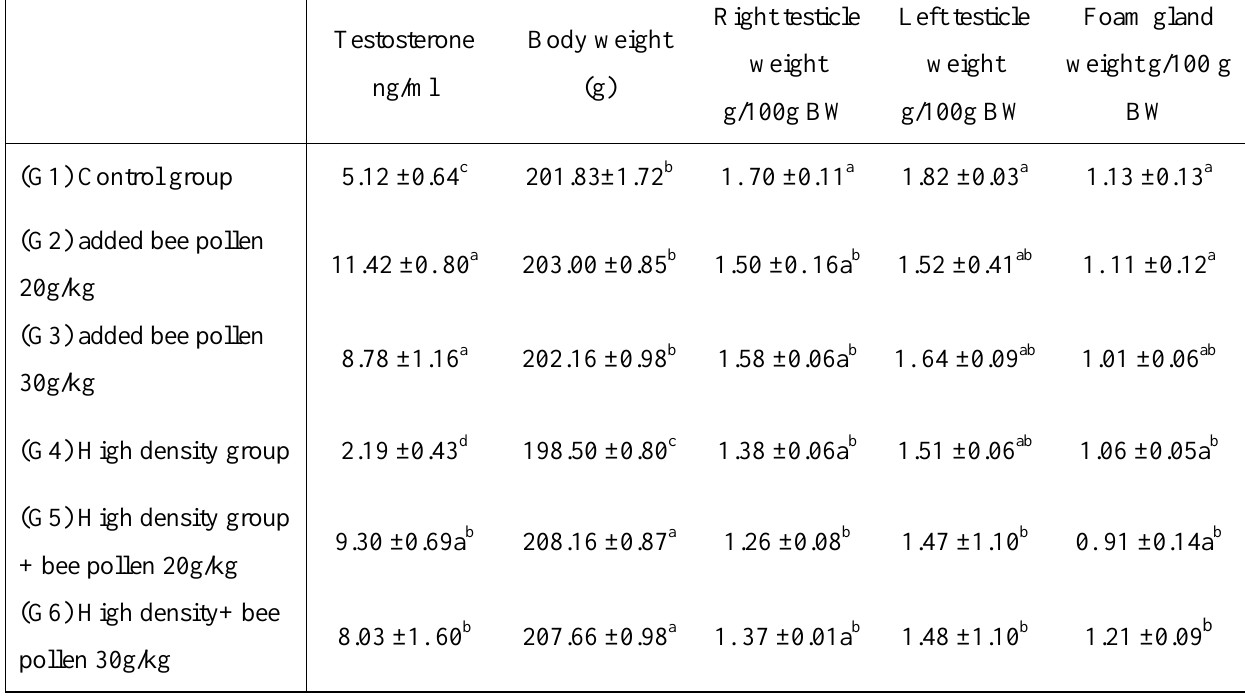
Table 2: Effect of high density of bird numbers and the addition of bee pollen to the diet on the concentration of testosterone, body weight, weight of right and left testis and foam gland weight of quail males ( Mean ± SE ):